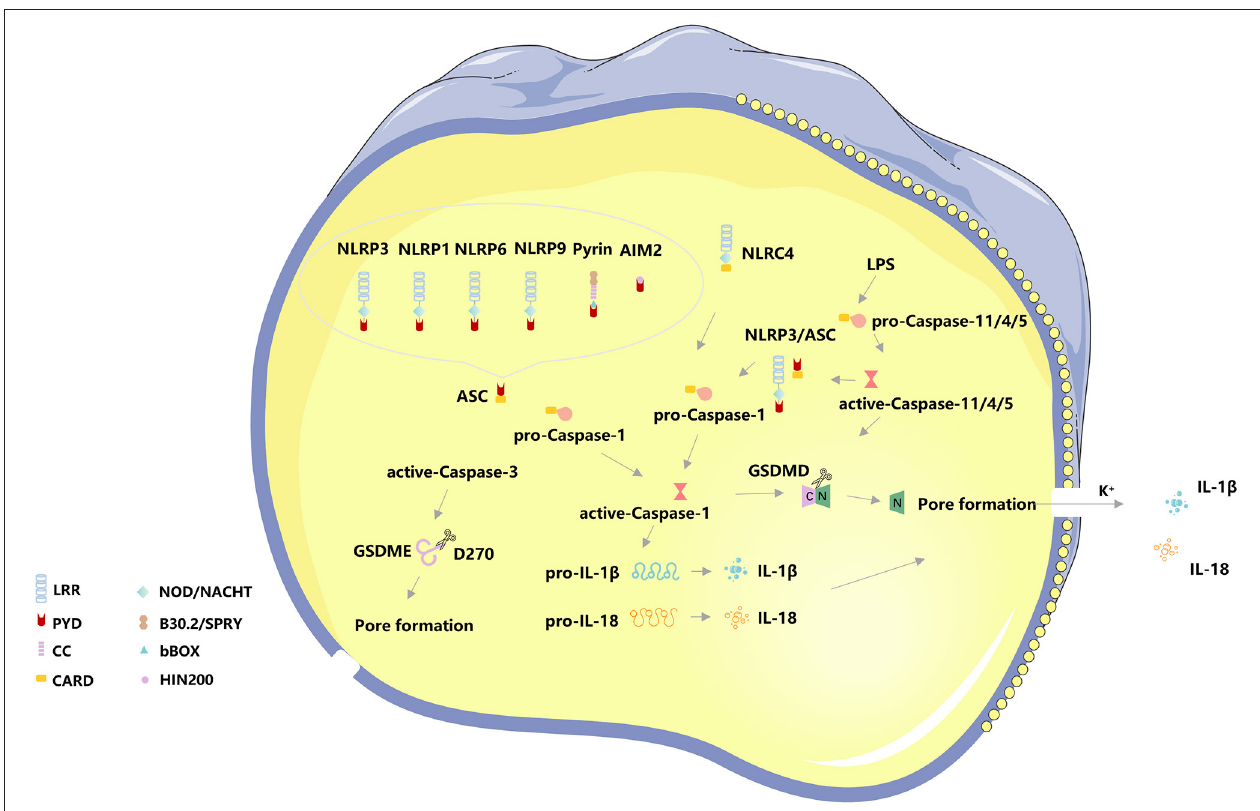
FIGURE 1 | The basic molecular mechanism of pyroptosis. The canonical pathway of pyroptosis, Nod-like receptors protein-3 (NLRP3), NLRP1, NLRP6, NLRP9, absent in melanoma 2 (AIM2), and Pyrin binds to the N-terminal PYD region of the apoptosis-associated speck-like protein (ASC) to activate ASC proteins through protein-protein interactions. The C-terminal CARD domain of ASC and the N-terminal CARD domain of pro-Caspase-1 combine to recruit active-Caspase-1. The binding complex of PRRs, ASC, and pro-Caspase 1 is termed the inflammasome. On the one hand, Caspase-1 recognizes pro-IL-1 β and pro-IL-18, converts them into IL-1 β and IL-18, and releases them extracellular to expand the inflammatory response, on the other hand, Caspase-1 shear Gasdermin family protein GSDMD to separate its N- and C- domains, N-terminal fragments are released to the membrane, mediating the formation of cell membrane pores, releasing inflammatory factors and inducing pyroptosis. NLRC4 can directly interact with pro-Caspase-1 via CARD-CARD to form active-Caspase-1 and induce pyroptosis. The non-canonical pathway of pyroptosis, Caspase4/5/11 can directly bind to lipopolysaccharide (LPS) in the cytoplasm and initiate pyroptosis following cleavage of GSDMD-induced membrane pore formation and subsequent cell membrane rupture. The K + efflux caused by cell membrane pore formation induces activation of the NLRP3/ASC/ Caspase-1 pathway. In addition, Caspase-3 cleaves the Gasdermin family protein GSDME, releasing the N-terminal active fragment to the cell membrane, leading to